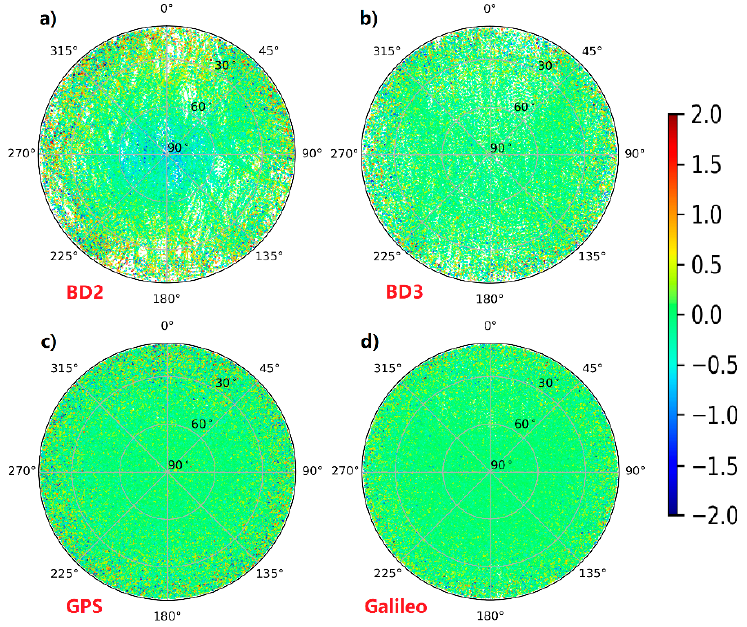
Figure 3. The BD2 ( a ), BD3 MEO satellites ( b ) together with the Global Positioning System (GPS) ( c ) and Galileo satellites ( d ) multipath combination versus elevation and azimuth (units: meter).